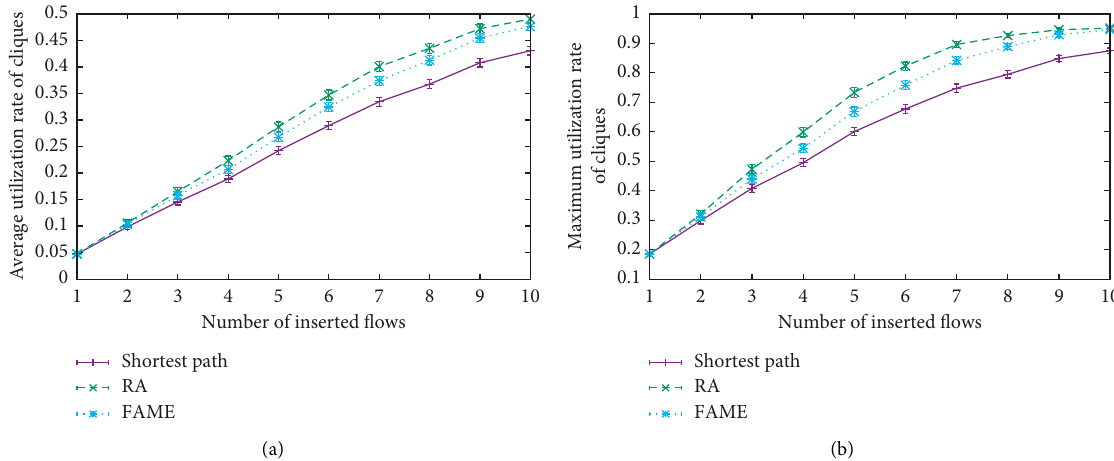
Figure 8: Load of the network through the cliques’ utilization rates. (a) Average utilization rate of cliques. (b) Utilization rate of the most used clique.